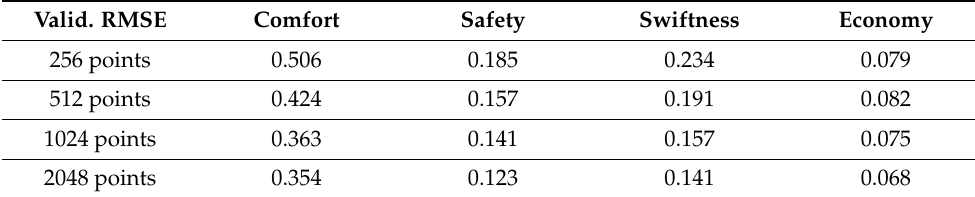
Table 4. Validation RMSE of the driving style aspects in the test sets. Valid. RMSE Comfort Safety Swiftness Economy 256 points 0.506 0.185 0.234 0.079 512 points 0.424 0.157 0.191 0.082 1024 points 0.363 0.141 0.157 0.075 2048